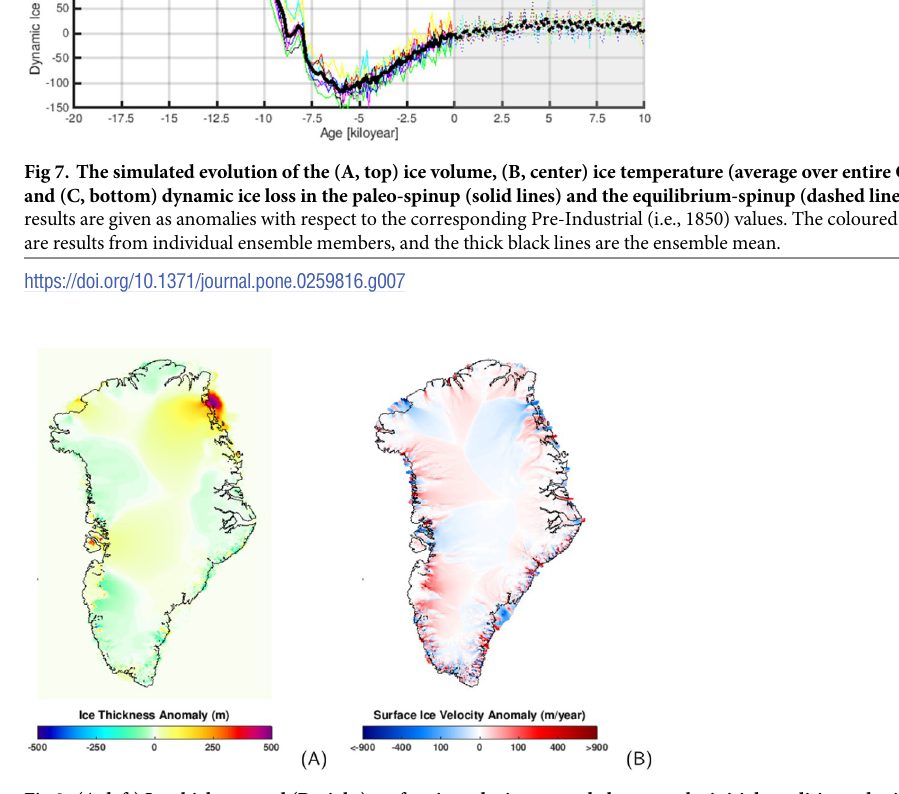
Fig 8. (A, left) Ice thickness and (B, right) surface ice velocity anomaly between the initial conditions obtained from the equilibrium-spinup and paleo-spinup (equilibrium minus paleo). Black line represents the coastline. As shown, individual glaciers have distinct responses. Overall, northeastern Greenland contributes to a larger GrIS ice volume in comparison with the that obtained from the paleo-spinup. With respect to the surface ice velocity, large portions of the GrIS show faster ice velocity in the equilibrium-spinup with respect to that obtained from paleo- spinup. Results are the ensemble mean of the seven ensemble members.